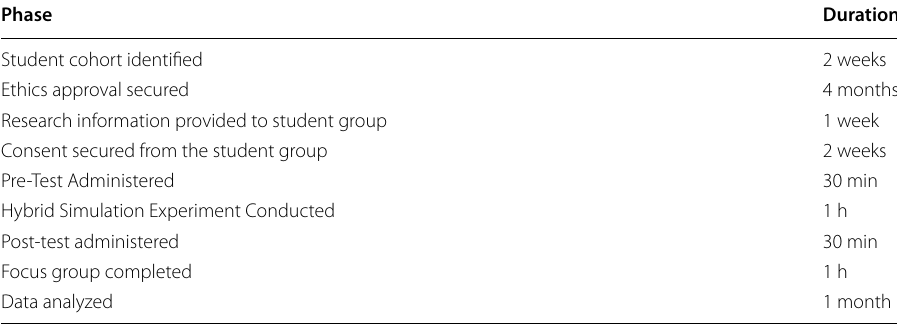
Table 1 Research